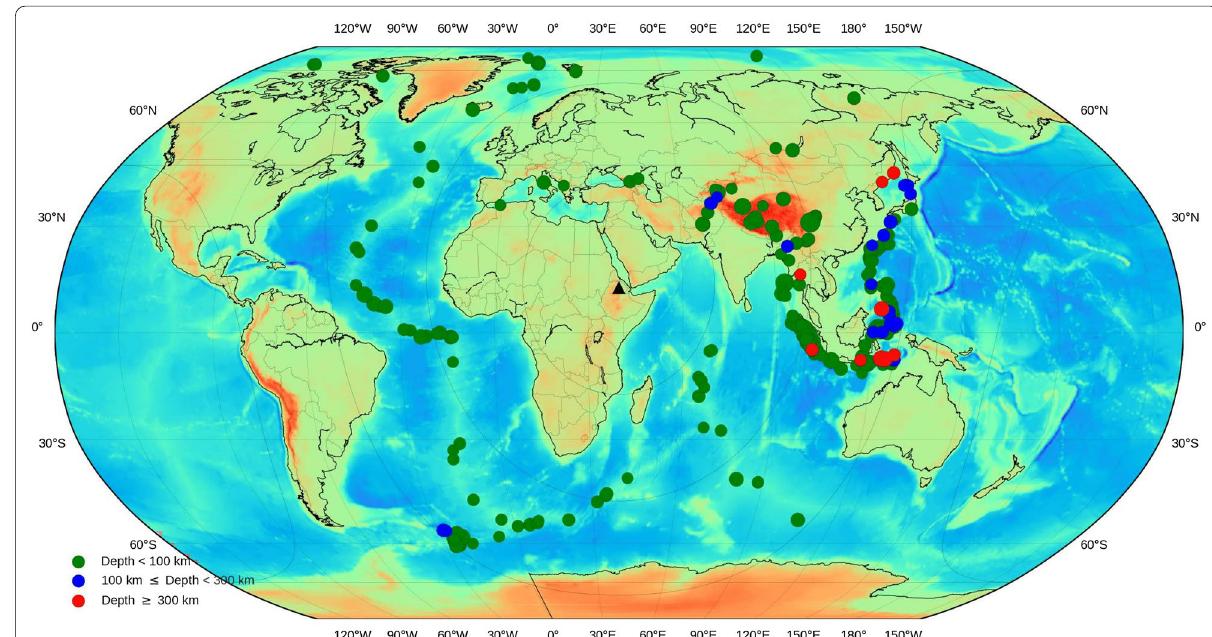
Fig. 3 Selected events used to compute the receiver functions for a single seismic station (ZF-MAYE). The seismic station is indicated by a black triangle, and the locations of the events are marked by circles, color-coded by epicentral